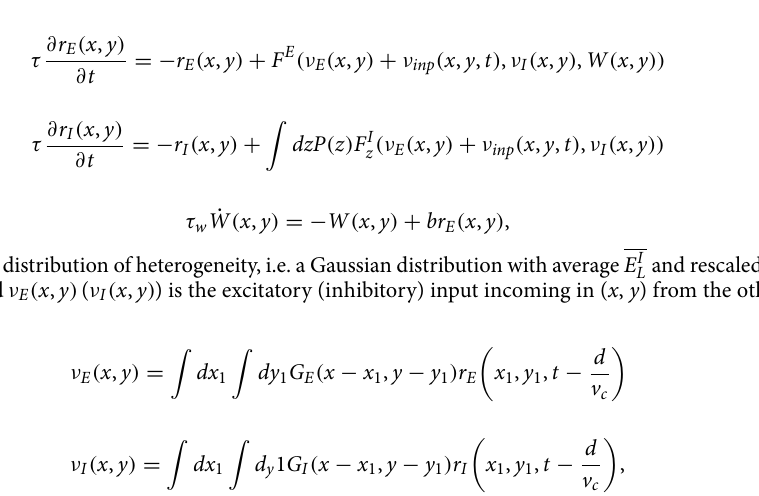
(inhibitory) connectivity in space. We consider a Gaussian connectivity in both directions with standard devia- tion (cid:31) E = 2 mm ( (cid:31) I = 1 mm) for excitatory (inhibitory) connections. We considered an axonal conduction velocity v c = 0.3 m/s. We considered an external stimulation as a stationary input ν inp ( x , y , t ) :